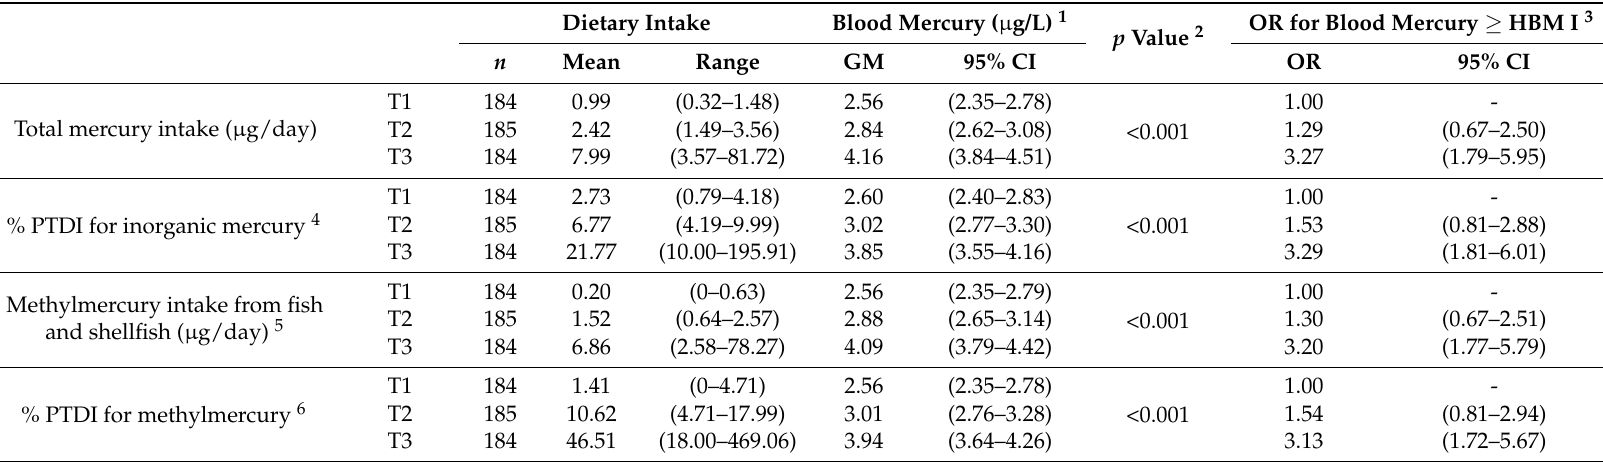
Table 4. The geometric means of the blood mercury concentration and the odds ratios for blood mercury ≥ the HBM I value according to the total mercury and methylmercury